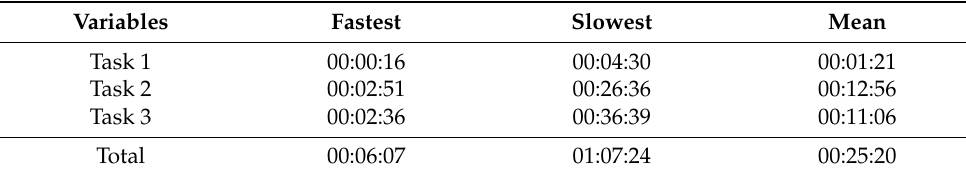
Table 2. Time needed to accomplish the